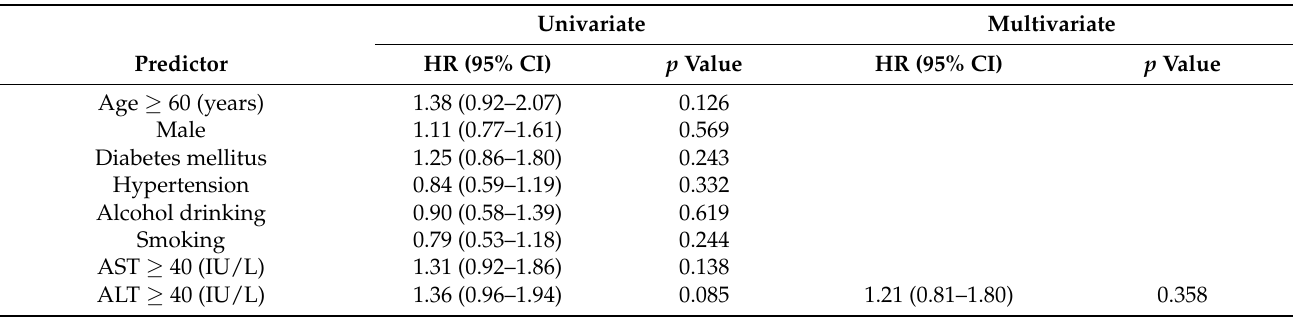
Table 3. Factors predictive of HCC recurrence.